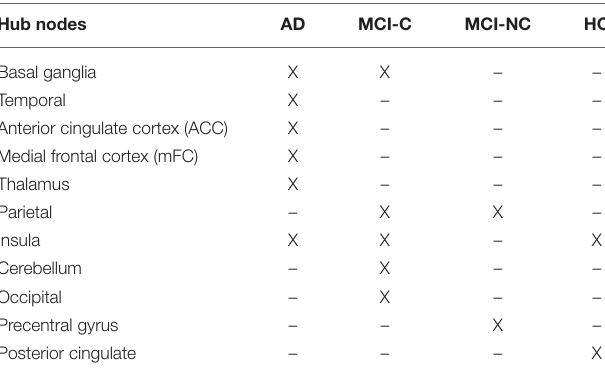
TABLE 5 | The rs-fMRI hub nodes in four groups of subjects (AD, HC, MCI-C, and MCI-NC). Hub nodes AD